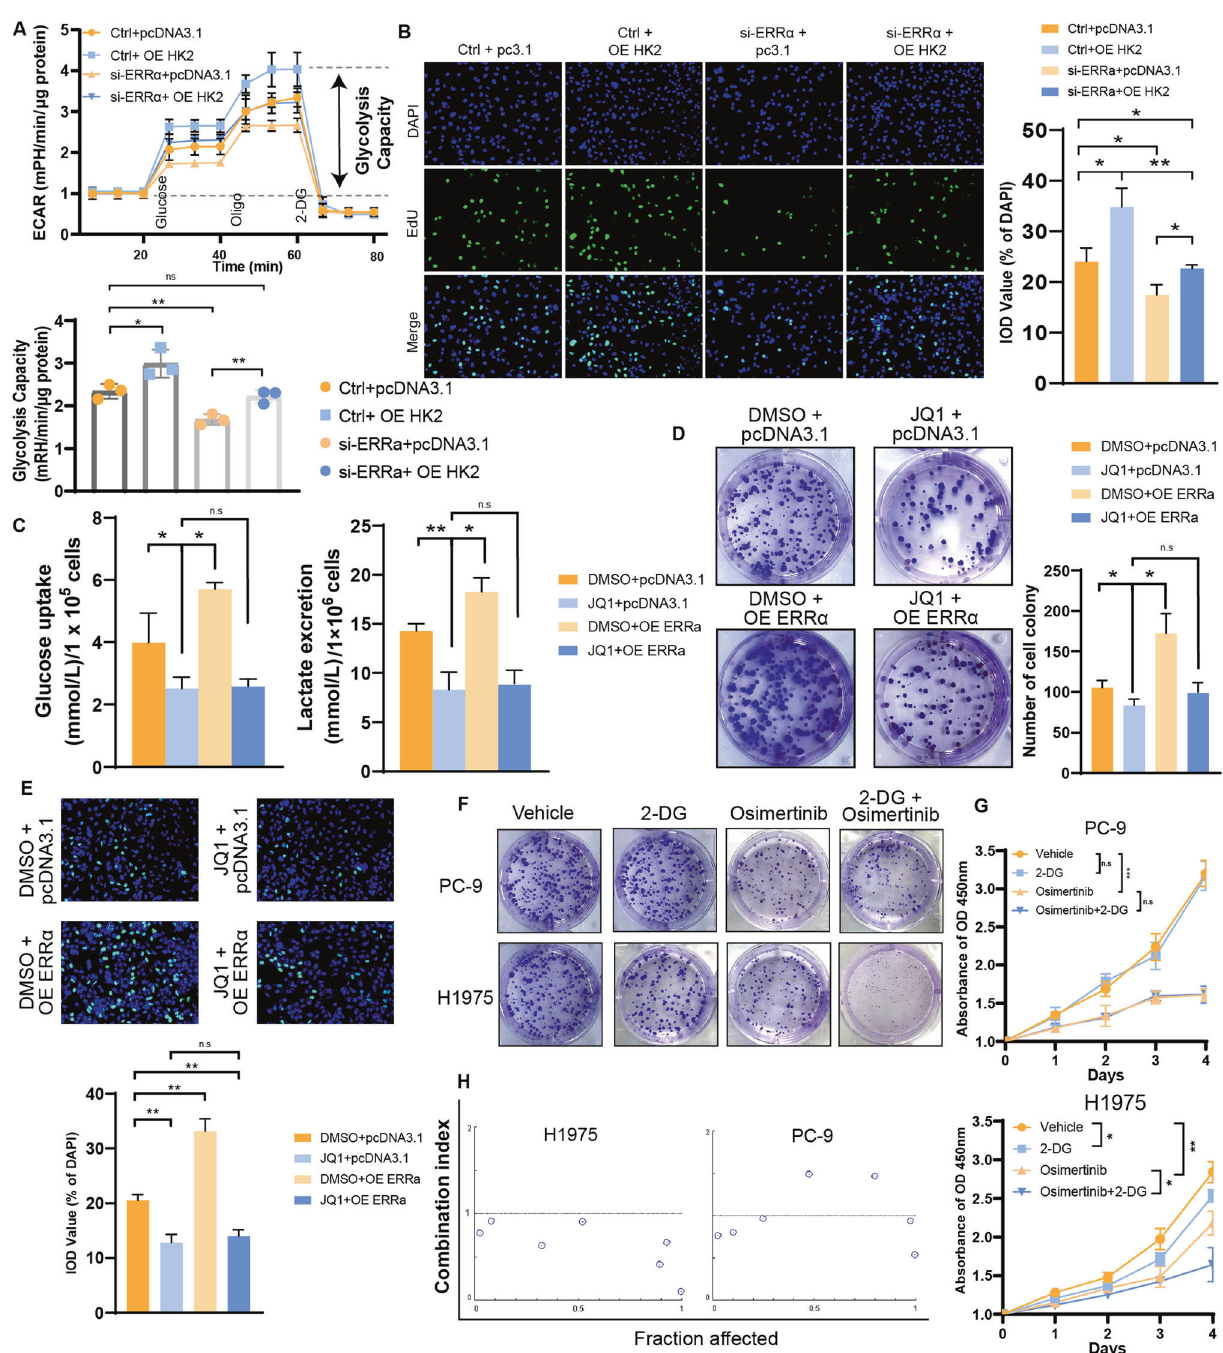
Fig. 5 ERR α assists SE to regulate aerobic glycolysis and malignant progression. A Extracellular fl ux assays showing that ERR α mediated aerobic glycolysis partly depends on regulating HK2 in DV90 cell line. B EdU assays showing that ERR α mediated malignant progression partly depends on regulating HK2 in DV90 cell line. Glucose uptake, lactate excretion ( C ), clone formation assay ( D ) and EdU assay ( E ) showing that ERR α mediated malignant progression partly depends on regulating SEs in DV90 cell line. Clone formation assay ( F ) and CCK-8 assay ( G ) revealing the inhibitory ef fi cacy of 2-DG, osimertinib and their combination in the EGFR mut cluster 3-like cell line (H1975) and EGFR mut non- cluster 3-like cell line (PC-9). H Combination index of 2-DG and osimertinib in the indicated cell lines. Combination index > 1 indicated antagonism, combination index < 1 indicated